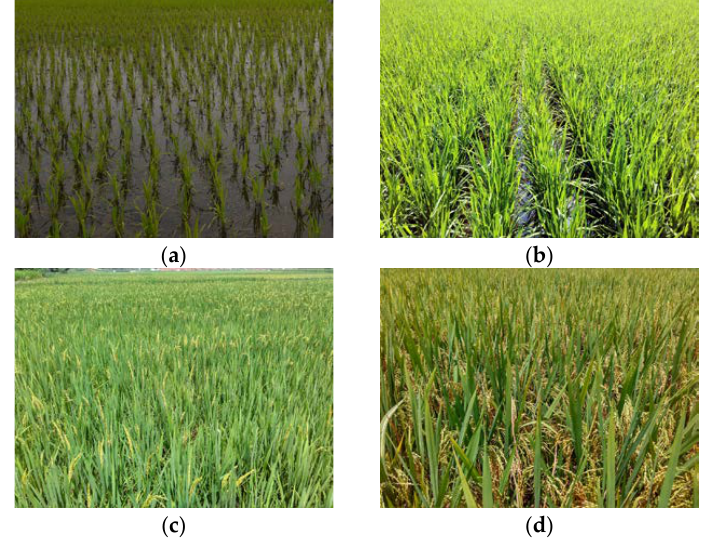
Figure 2. Four rice phenological phases in the study area in 2016. ( a ) transplanting, ( b ) vegetative, ( c ) reproductive, and ( d ) maturity.